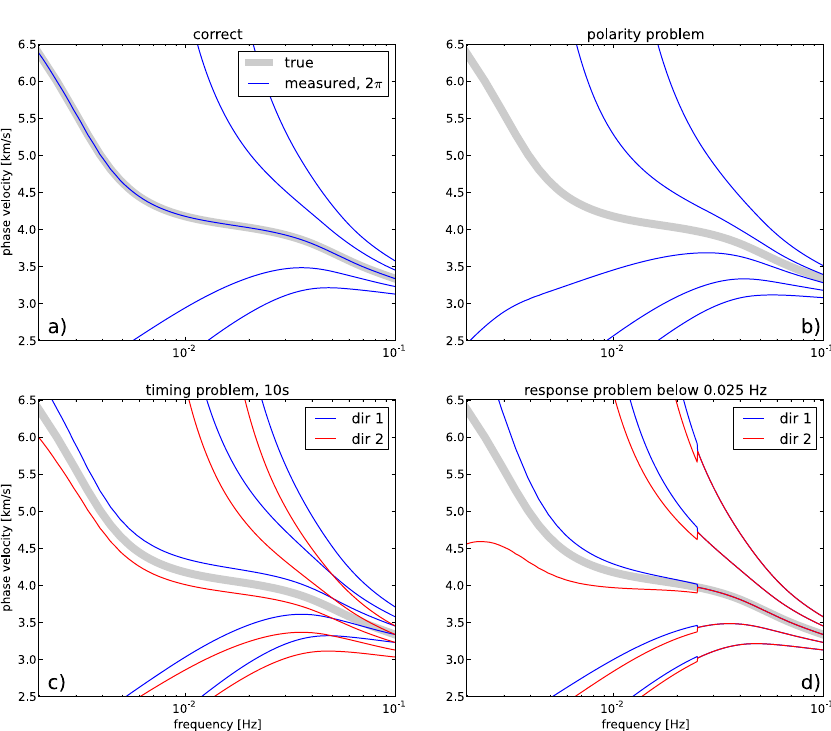
Fig. 1. Simulation of potential data errors in the inter-station phase velocity measurement. Synthetic waveforms are simulated in PREM (Dziewonski and Anderson, 1981) for epicentral distances of 5000 and 6000km. For description see